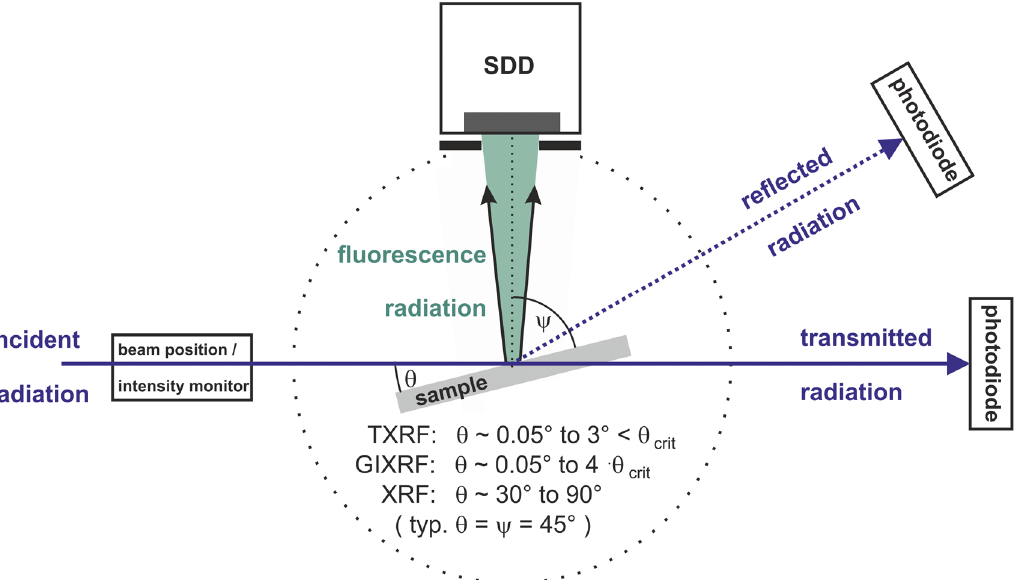
Figure 1. Different experimental configurations of reference-free XRF using monochromatized SR as the incident excitation radiation. In the first UHV instrumentation for reference-free XRF, the solid angle of detection is defined by a well-known diaphragm placed in front of the calibrated SDD detector at a given distance with respect to the center of the sample. In order to take advantage of the linear polarization of SR for reducing spectral background, the angle between the incident radiation and the fluorescence detection channel is 90°. When simultaneously detecting fluorescence radiation with two SDDs, normal incidence (θ = 90°) and observation angles ψ of the detectors of 30°, 45° or 60°, with respect to the sample surface, are chosen. θ crit designates the critical angle of external total reflection at a flat sample surface. Calibrated photodiodes are employed to determine the incident radiant power or intensity of the excitation radiation.